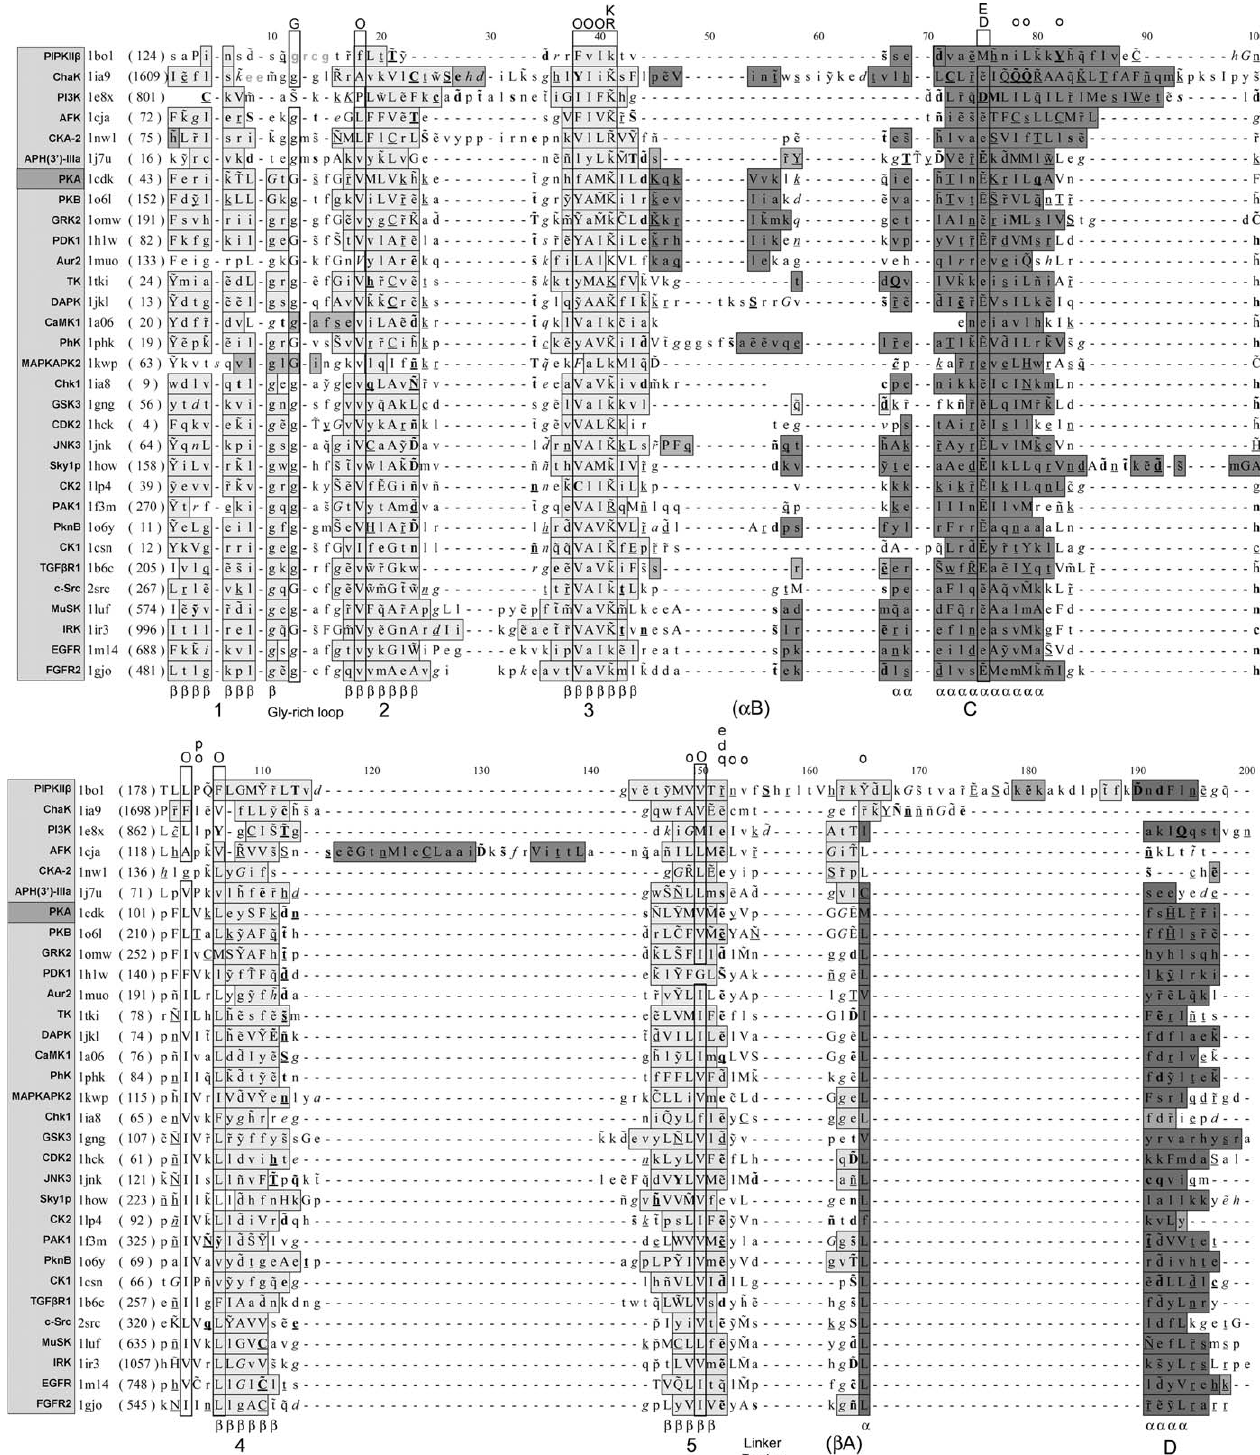
Figure 3. Enhanced Sequence Alignment Derived from the Structural Alignment of Kinase Representatives Abbreviated names of kinase representatives are provided with the gray box at the left-hand side of the figure (see Table 1 for more information on structures). The name is followed by the PDB ID [18] for the structure used in the alignment. The number in parenthesis following the PDB ID is the residue number of the first residue shown in the alignment. The sequences of the six AKs are clustered at the top of the alignment, followed by the sequence of PKA, which is highlighted. The alignment is annotated for key structural features using the JOY software [78]. Secondary structure is represented using the following conventions: light-gray box, b -strand; medium-gray box, 3–10 helix; dark-gray box, a -helix. Residue characteristics are represented using the following conventions: uppercase, solvent inaccessible; lowercase, solvent accessible; bold, hydrogen bond to main chain amide; underline, hydrogen bond to main chain carbonyl; tilde, hydrogen bond to other side-chain; italic, positive U ; breve, cis -peptide. Residues that are highly conserved within the TPK family and some AKs are highlighted in boxes for the sequences where the conservation applies. The residue(s) seen at PLoS Computational Biology |